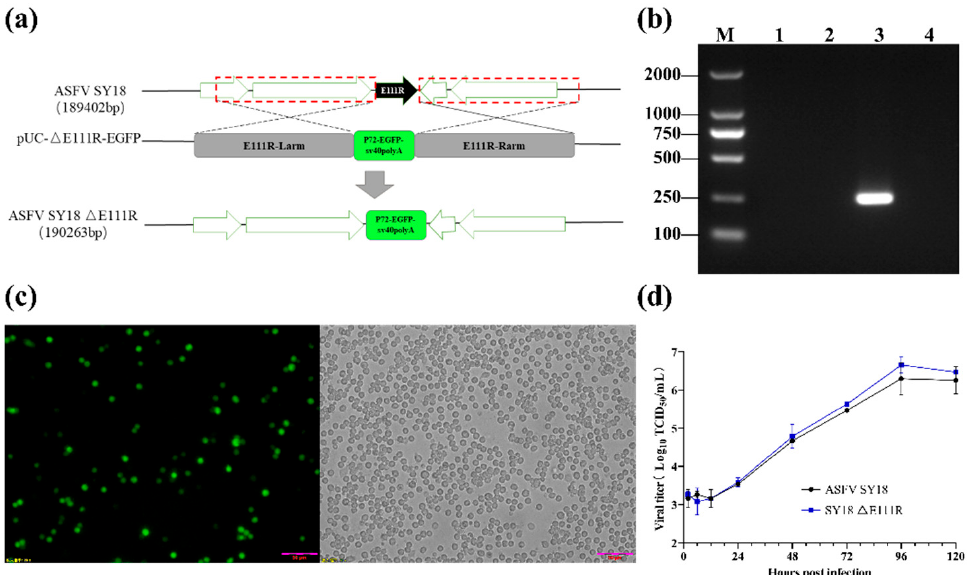
Figure 1. ASFV SY18 ∆ E111R construction and in vitro growth characteristics. ( a ) Schematic diagram of SY18 ∆ E111R recombinant virus construction. ( b ) The PCR amplification results of the E111R gene of genomic DNA. M, DL2000 DNA Marker; (1) PCR product of the E111R gene of the 1st-generation SY18 ∆ E111R strain; (2) PCR product of the E111R gene of the 2nd-generation SY18 ∆ E111R strain; (3) PCR product of the E111R gene of the ASFV SY18 strain; (4) negative control. ( c ) PAMs were infected by 2nd generation SY18 ∆ E111R after 96 h (20 × , scale bar 50 µ m). The 2nd generation SY18 ∆ E111R infected cells express green fluorescence (left), bright field plot of the 2nd generation SY18 ∆ E111R strain-infected cells (right). ( d ) In vitro growth characteristics of the 2nd generation SY18 ∆ E111R and ASFV SY18. Both viruses infected PAMs at 0.01 MOI and titrated for viral yield at 2, 6, 12, 24, 48, 72, 96, and 120 hpi; data representing the mean of the three independent experiments’ results are expressed as log10 TCID 50 /mL. Data are not significantly different for all time points ( p > 0.05).